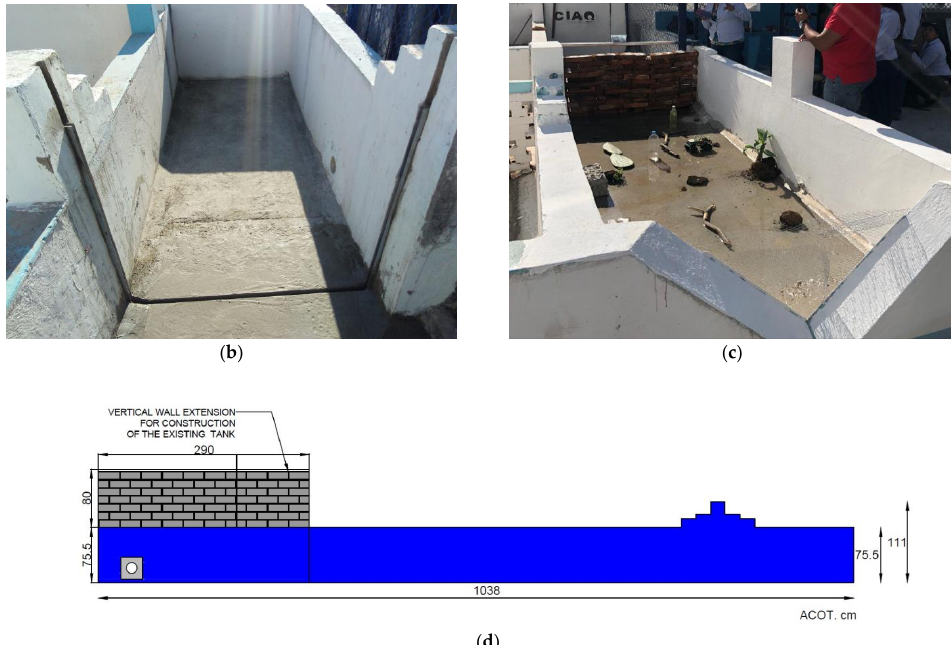
Figure A1. Dimensions of Forensic hydraulics channel and an instantaneous opening gate, plant and cross section. ( a ) A floor plan of the forensic channel. ( b ) Reservoir tank. ( c ) Triangular spillway used in the forensic channel, and ( d ) profile view of the forensic channel. Table A2. Frequency analysis. Historical flow data in m 3 /s for the proposed example river.